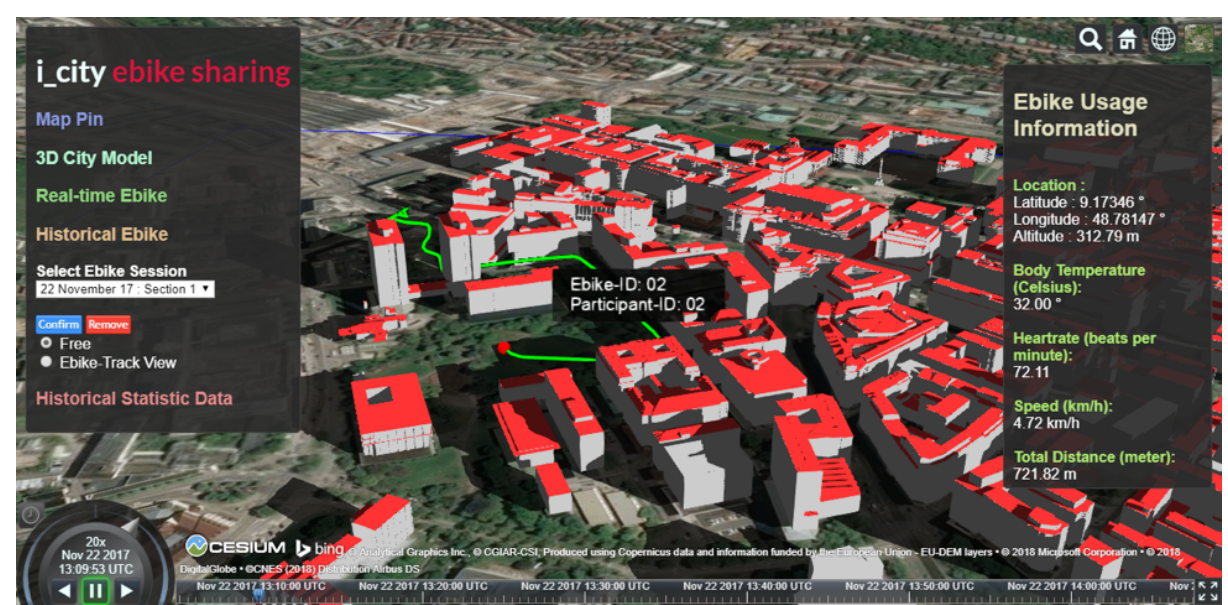
Figure 5: 3D application with pedelec usage information displayed for a single participant using an